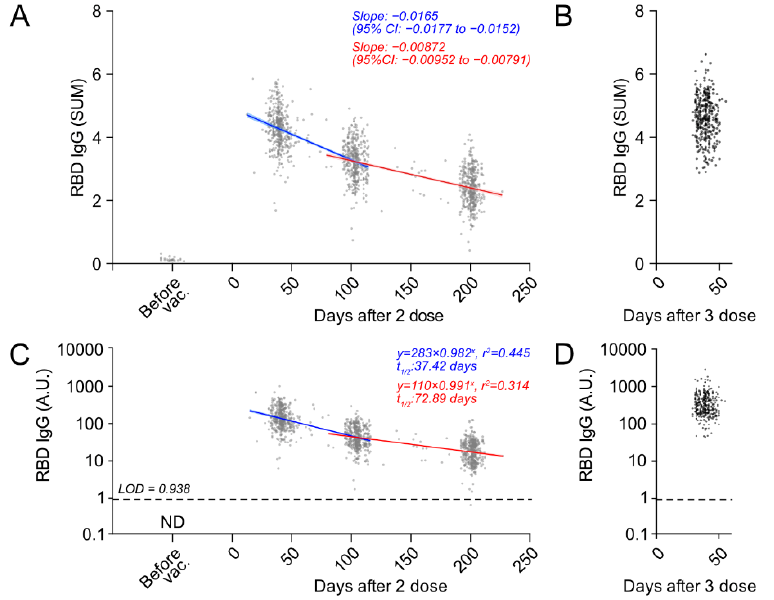
Figure 4. Longitudinal kinetics of anti-SARS-CoV-2 RBD IgG antibodies after the second and third doses of the BNT162b2 vaccine. ( A ) Linear regression analysis of a total of 1252 samples of post-vaccination from 431 subjects. Antibody titers (SUM) of the pre-vaccination phase from randomly selected 24 participants are also shown. The sum of ABS 450 values of six serial 4-fold dilutions (SUM) from each serum sample are analyzed. Linear regression models are fitted to the data from the peak humoral response (1 M) to 3 M (blue) and the data from 3 M to 6 M (red), respectively. ( B ) Anti-RBD IgG antibody titers (SUM) at 1 M after a third dose of BNT162b2(3D-1M) are shown. ( C ) Antibody titers (A.U.) of each sample are determined by standard human IgG monoclonal antibody against SARS-CoV-2 S1 protein. The half-life of antibody titer is calculated from the regression coefficients (37.42 days (95% CI: 34.80–40.46) and 72.89 days (95% CI: 66.23–81.02), respectively). Antibody titers of pre-vaccination phase from randomly selected 24 participants were under the limit of detection. LOD: limit of detection. ( D ) Anti-RBD IgG antibody titers (A.U.) at 1 M after a third dose of BNT162b2(3D-1M) were shown.